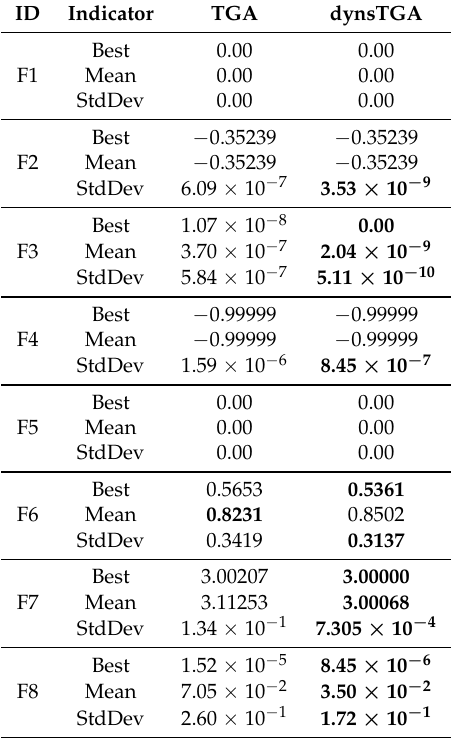
Table 2. Comparative analysis—tree growth algorithm (TGA) vs. dynamic search TGA (dynsTGA) (best results for each performance indicator are marked